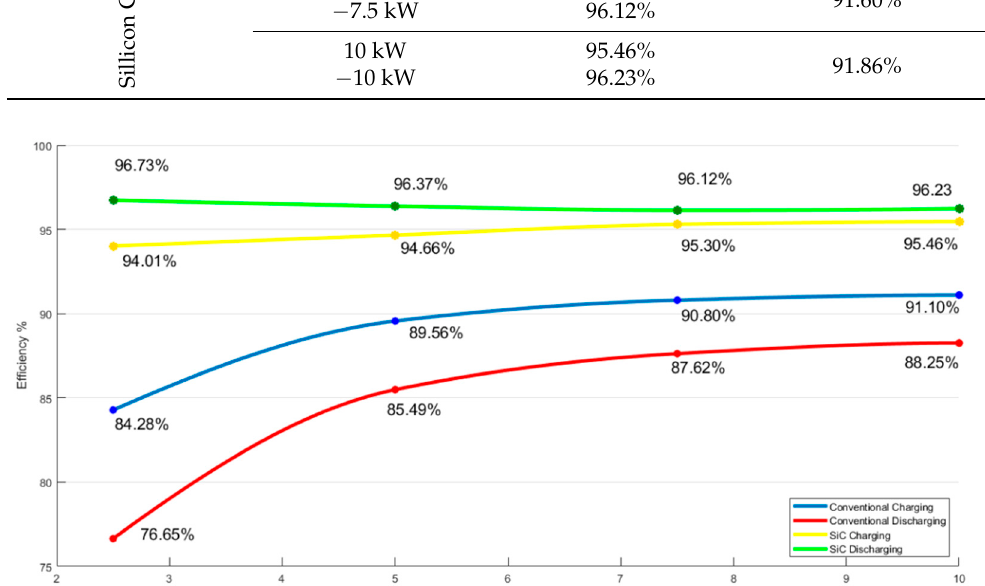
Figure 6. Charger Efficiency Comparison: SiC vs. conventional chargers.